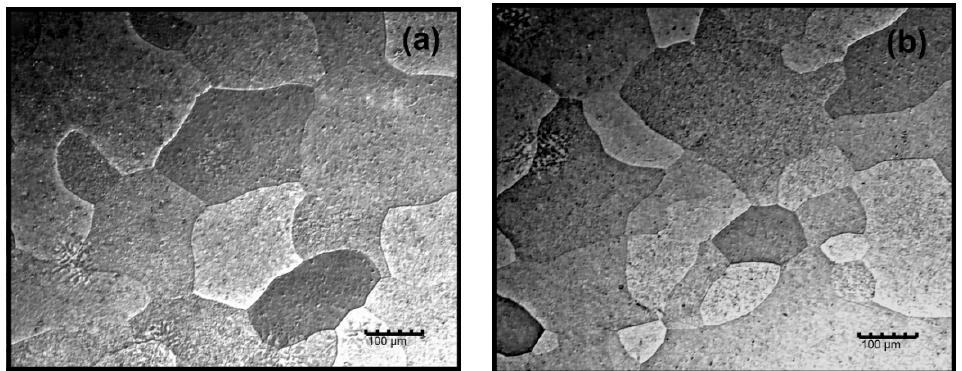
Figure 3. Microstructure after solution treatment at 640 °C and cooling in water. ( a ) Alloy-I, 0.38% Zr; ( b ) Alloy-II, 0.43% Zr.